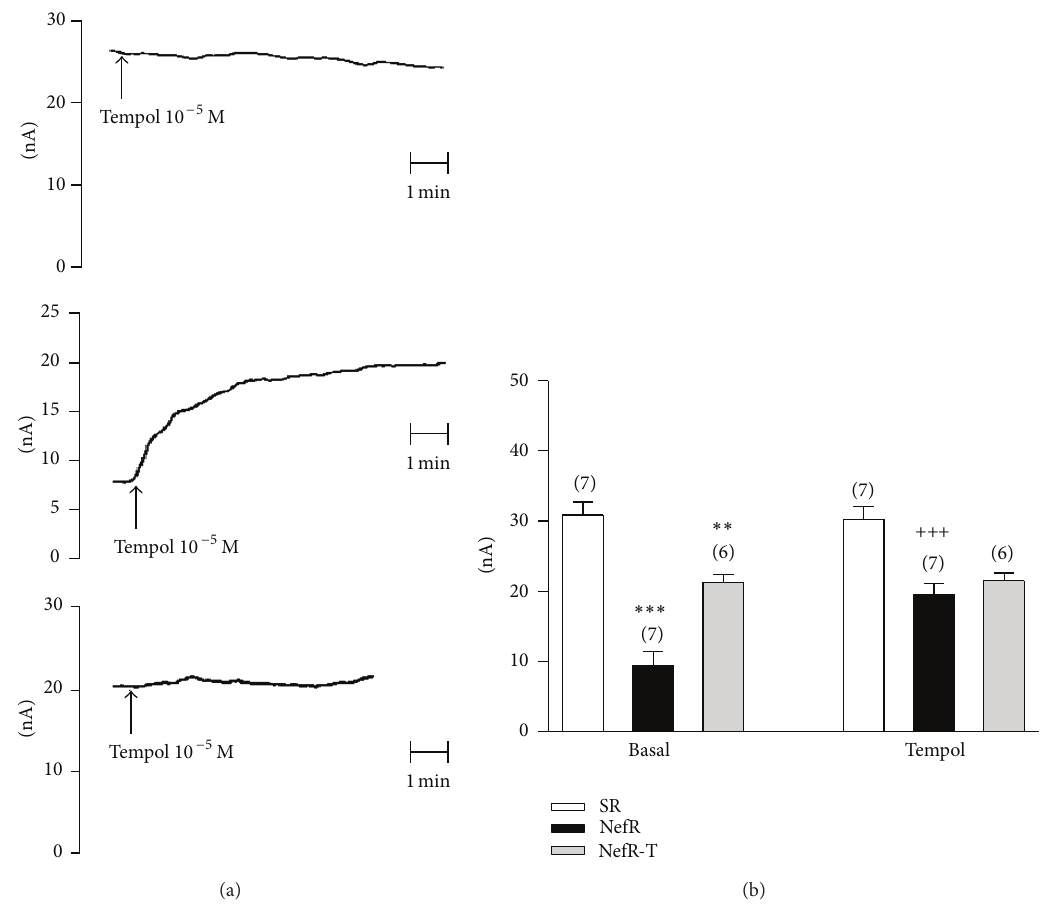
Figure 3: Effect of tempol 10 −5 M on NO levels (a) Typical experiment of direct measurement of NO in unrubbed aortic rings from SR (upper), NefR (middle), and NefR-T (lower) and the effect of tempol (arrows). (b) Average of effect of tempol on direct measurement of NO in unrubbed aortic rings of SR (white bars), NefR (black bars), and NefR-T (gray bars). ∗∗ 𝑃 < 0.01 NefR-T versus SR; ∗∗∗ 𝑃 < 0.001 NefR versus SR; +++ 𝑃 < 0.001 tempol versus basal. Two way ANOVA. Data are expressed as mean ± standard error. The number of rings is given in parentheses.